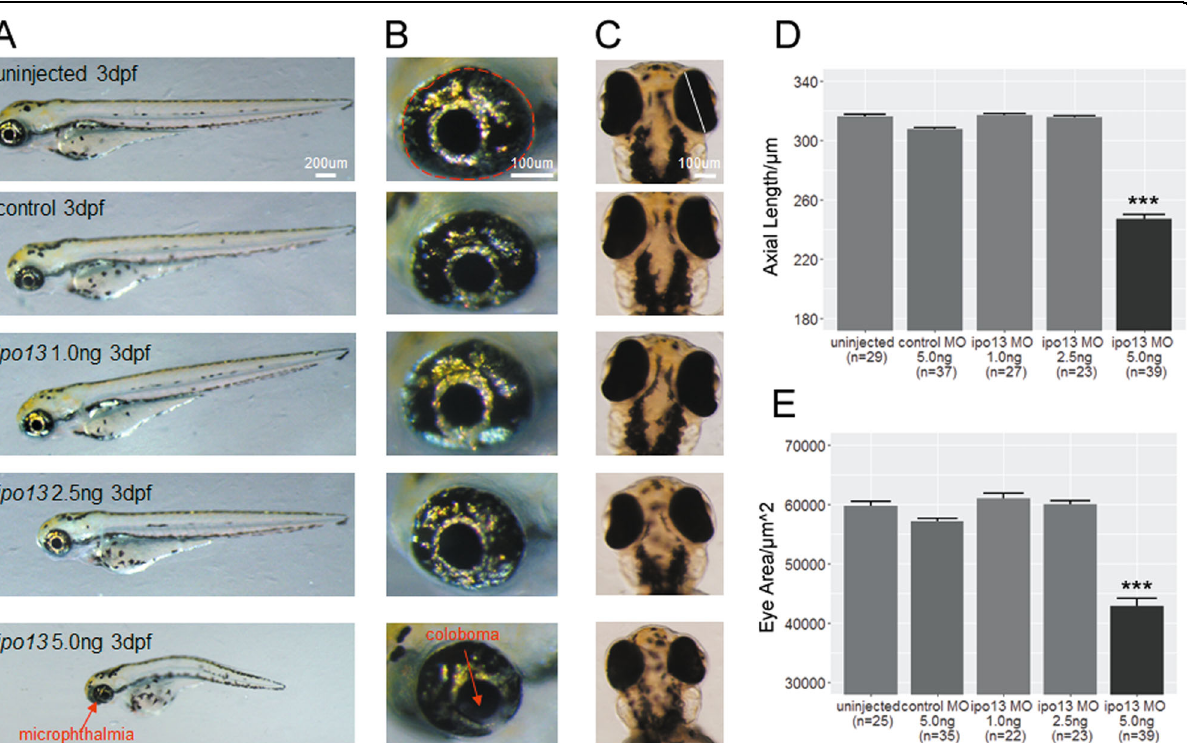
Fig. 3 Morphology of ipo13 -de fi cient zebra fi sh morphants. a Lateral view of zebra fi sh larvae. Larvae injected with the highest does of ipo13 targeting MO at 5.0 ng/µL exhibit apparent spinal curvature and reduced eye size. Abnormalities were not observed in the low concentration groups. b Magni fi ed lateral pictures of zebra fi sh eyeballs show signi fi cant decrease in eye size. c Vertical view of larval eyeballs displays shorter axial length in the highest MO dose group. d , e Quanti fi cation of the eyeball axial length ( d ) and eye area ( e ). The axial length and eye area are represented as a white line and red circle, respectively. Student ’ s t -test, values are means ± s.e.m. *** P <